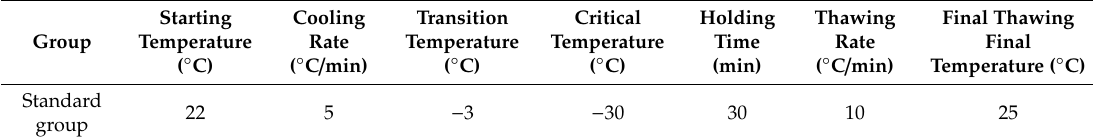
Table 1. Standard experimental scheme.